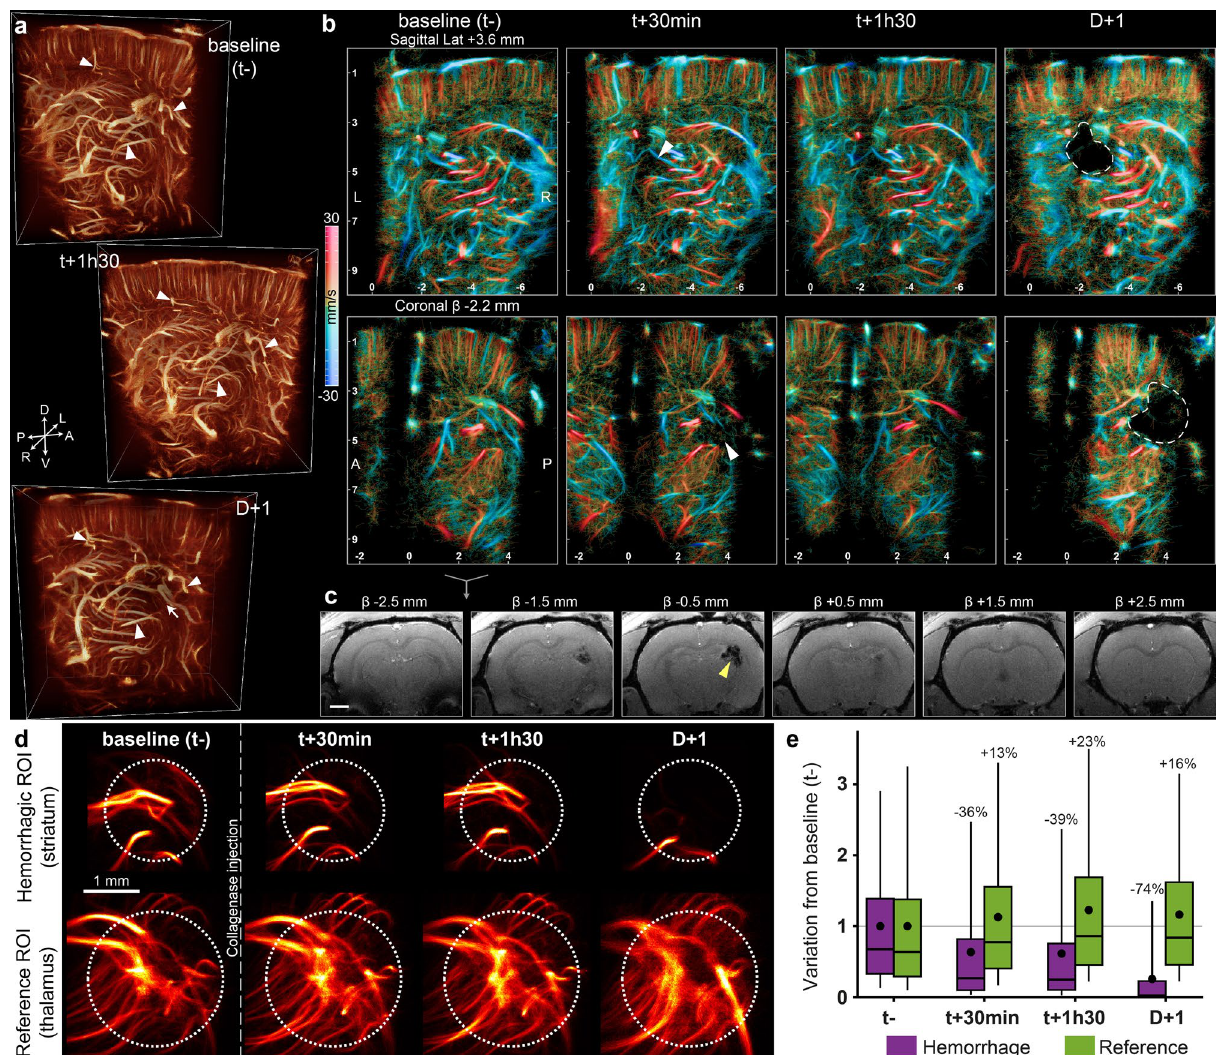
Figure 5. Collagenase induced hemorrhage in the striatum observed with 3DULM in the early phase. (a) 3D renderings before, and 1h30 after stroke’s induction, and the day after (Supplementary Video S2). ( b) Sagittal and coronal slices of 600 µm with velocity rendering at different timepoints. Hemorrhagic core wrapped with a white dotted line. V max = 30mm / s . Upward flow: red, downward flows: blue. ( c) T2* MRI at D + 1. Scale bar: 2 mm. Yellow arrow targets the hemorrhagic core. ( d) Projection of the selected ROI in the cortex and thalamus as a reference. ( e) MDI values for the ROI inside the hemorrhagic core and the reference normalized with the baseline. (Results of the analysis of 1 animal over 5.) Figures were created with ( a ) Amira 2019.4 (https:// www. therm ofish er. com/ amira- avizo), ( b–e ) MatLab 2019a (https:// www. mathw orks. com/ produ cts/